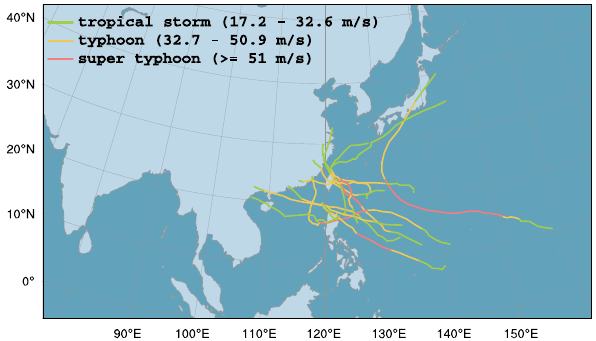
Figure 1. Domain of the TWRF and CWB best tracks of typhoons listed in Table 1. The curves indicate the track for each typhoon during its life cycle. Colors of different segments of each curve des- ignate different stages of the corresponding storm.